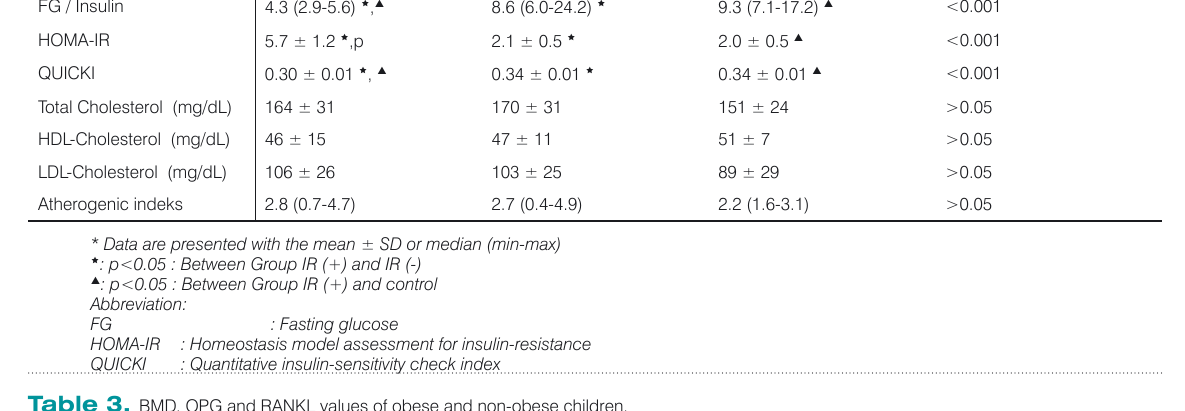
Table 3. BMD, OPG and RANKL values of obese and non-obese children.